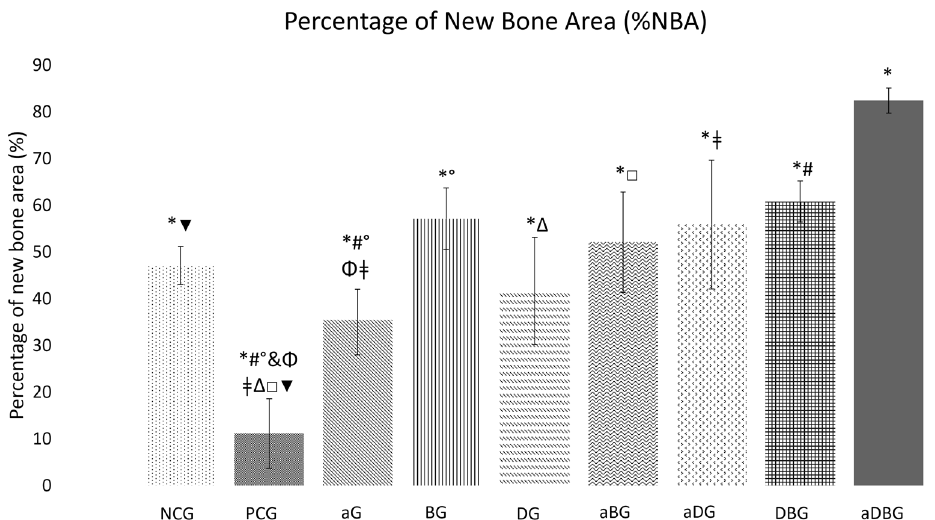
Figure 9. Graph representing the group-wise average percentage of the neoformed bone area ( p < 0.05, represented by *, when compared to aDBG; #, when compared to DBG; ǂ , when compared to aDG; °, when compared to BG; □ , when compared to aBG; Δ, when compared to DG; Φ, when compared aG; ▼ , when compared to